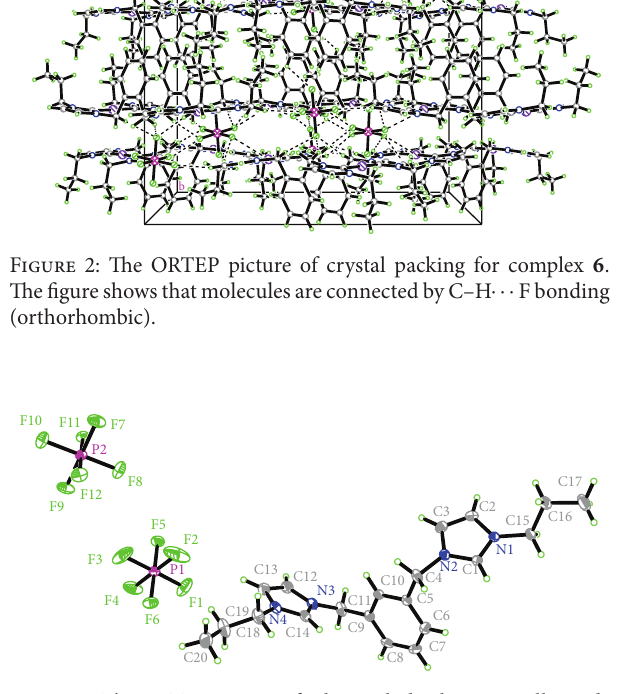
Figure 3: The ORTEP picture of salt 5 with displacement ellipsoids drawn at 50% probability